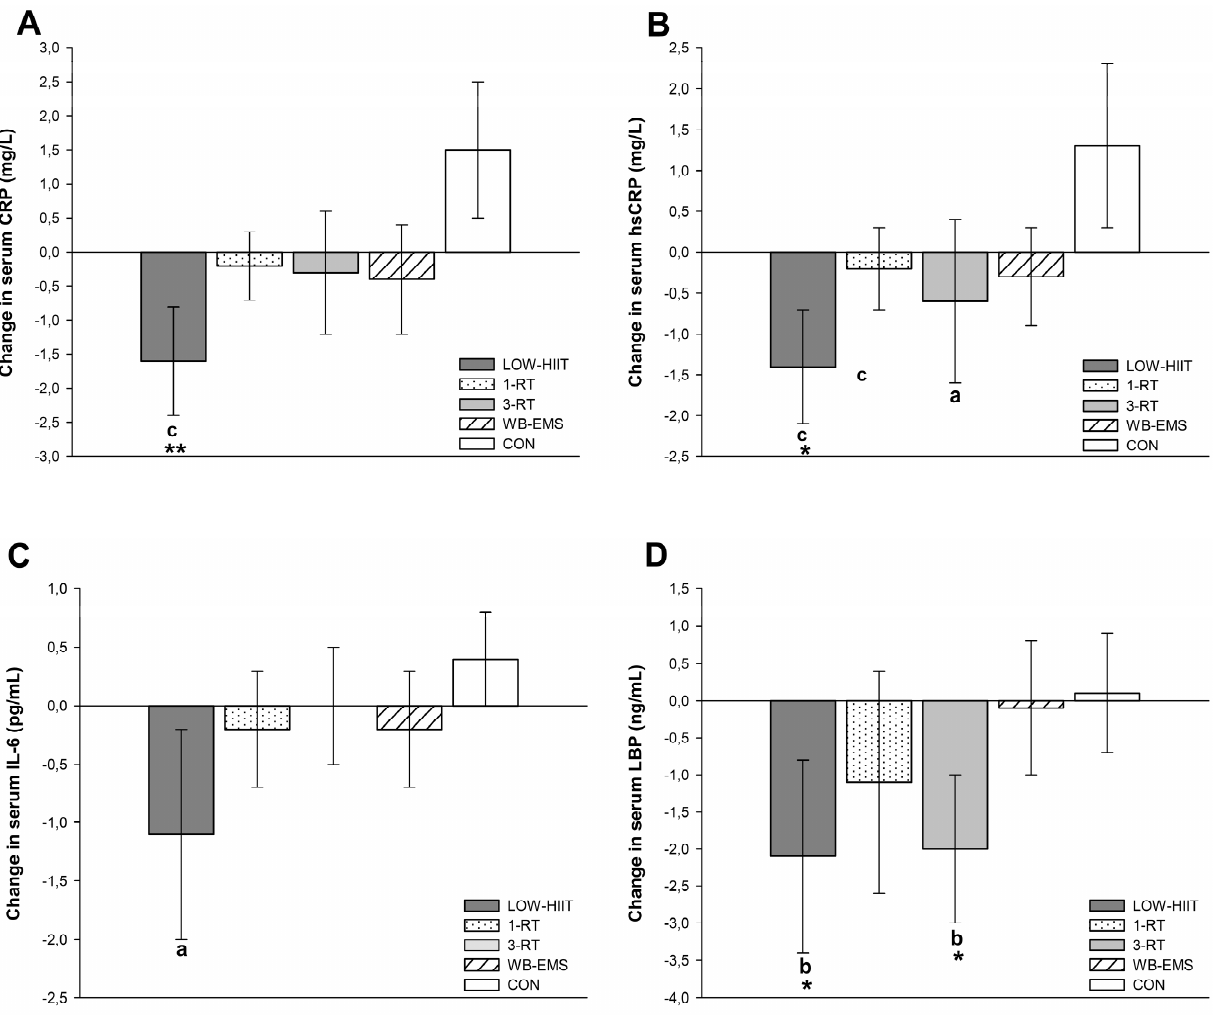
Figure 2. Changes in serum concentrations of C-reactive protein ( A ), high-sensitivity C-reactive pro- tein ( B ), interleukin-6 ( C ), lipopolysaccharide-binding protein ( D ), and changes in MetS z-score ( E ) and body weight ( F ). a ( p < 0.05), b ( p < 0.01), c ( p < 0.001): significant difference versus pre-interven- tion; * ( p < 0.05), ** ( p < 0.01): significant difference versus CON; ++ ( p < 0.01): significant difference versus WB-EMS. 3.4. Inflammatory Markers A significant group-by-time interaction was found for CRP ( p = 0.022, ή 2 = 0.11), hsCRP ( p = 0.028, ή 2 = 0.10) and LBP ( p = 0.011, ή 2 = 0.13). Main effects of time were detected for IL-6 ( p = 0.048, W = 0.37) and LBP ( p < 0.001, ή 2 = 0.14). Post-hoc tests showed significant reductions in serum concentrations of CRP ( − 1.6 mg/L, 95% CI: − 2.4 to − 0.7 mg/L, p < 0.001), hsCRP ( − 1.4 mg/L, 95% CI: − 2.1 to − 0.6 mg/L, p < 0.001), IL-6 ( − 1.1 pg/mL, 95% CI: − 2.0 to − 0.2 pg/mL, p = 0.020), and LBP ( − 2.1 ng/mL, 95% CI: − 3.4 to − 0.7 ng/mL, p = 0.004)